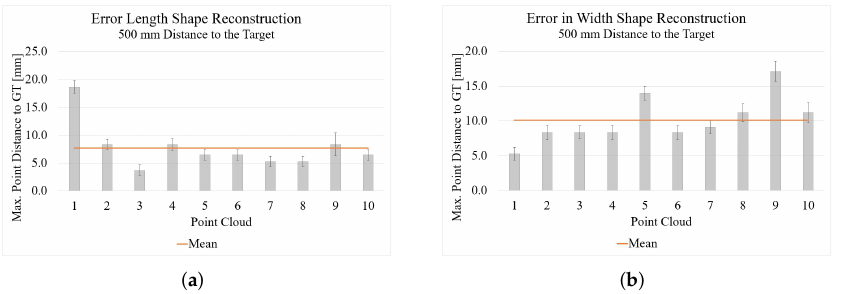
Figure 14. Results of the shape reconstruction of length and width with the Intel RealSense D455: ( a ) length reconstruction; ( b ) width